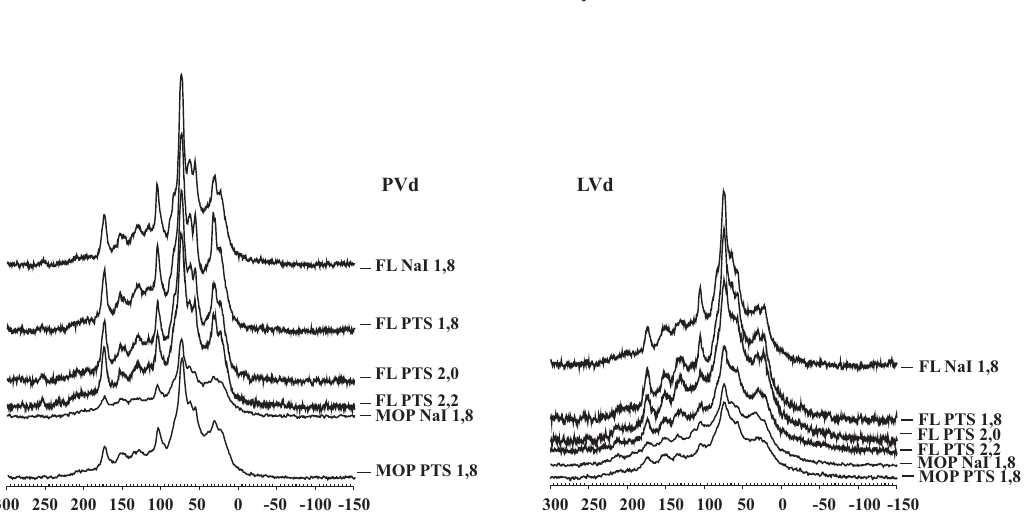
Figura 4. Espectros de RMN 13 C da fração leve (FL) e da matéria orgânica residual (MOP) de um Argissolo Vermelho (PVd) e de um Latossolo Vermelho (LVd) obtida em fracionamento densimétrico com soluções de iodeto de sódio (NaI) e de politungstato de sódio (PTS).